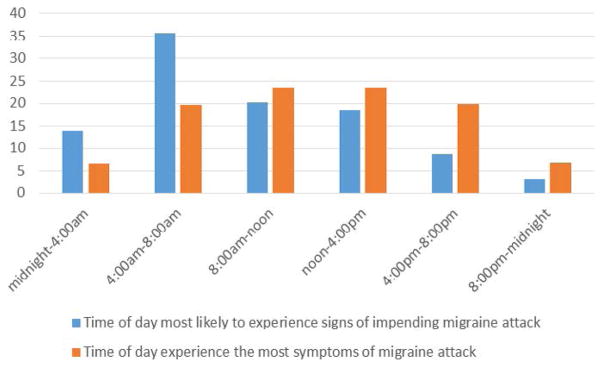
Migraine symptoms and attacks by time of day.